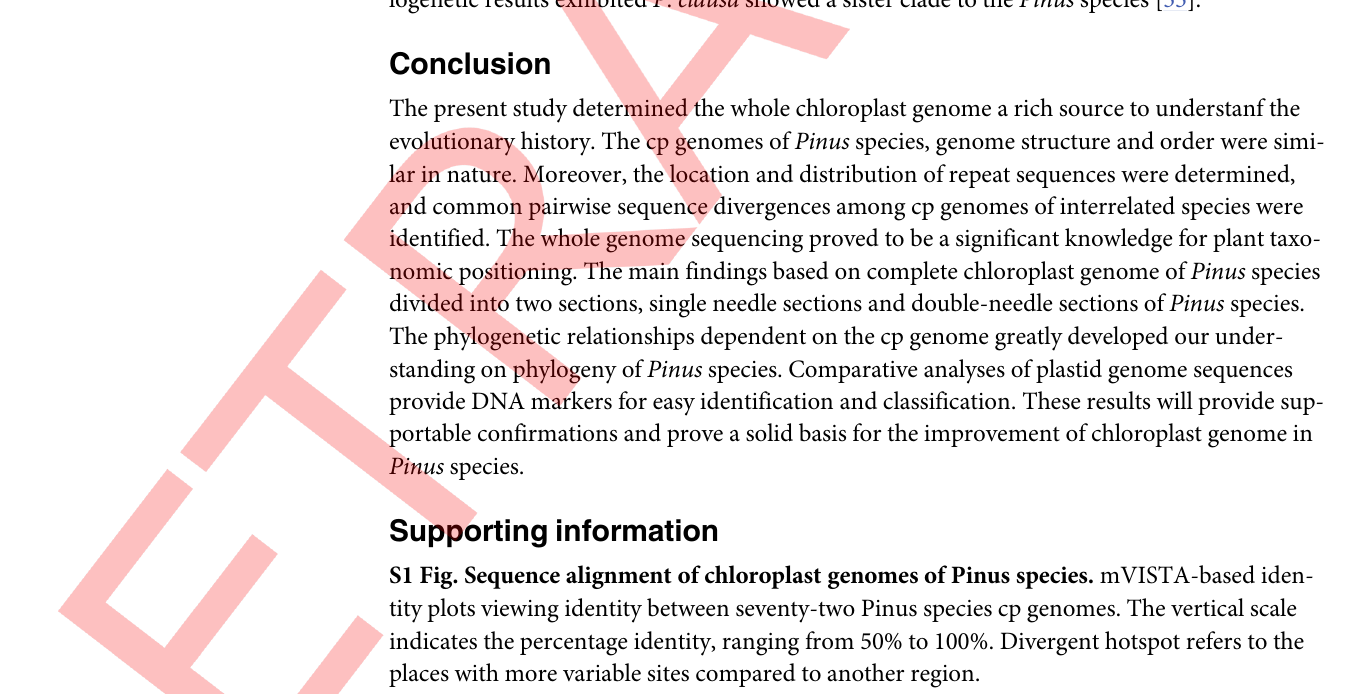
S1 Fig. Sequence alignment of chloroplast genomes of Pinus species. mVISTA-based iden- tity plots viewing identity between seventy-two Pinus species cp genomes. The vertical scale indicates the percentage identity, ranging from 50% to 100%. Divergent hotspot refers to the